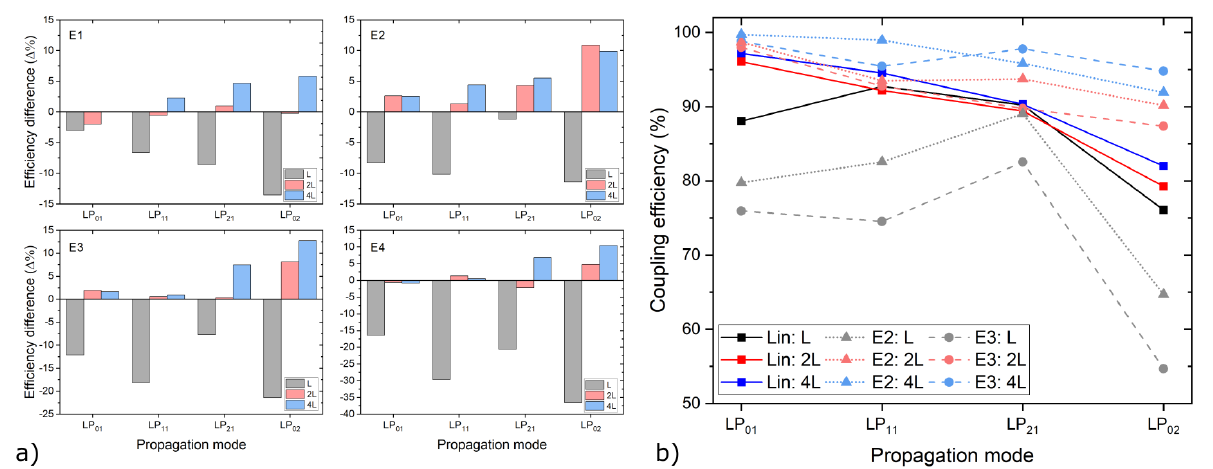
Figure 8. ( a ) Coupling efficiencies for the structures E2 and E3 compared with a traditional linear profile for different transmission lengths. ( b ) Differential modal coupling efficiencies referenced a traditional linear profile for all the possible MFA